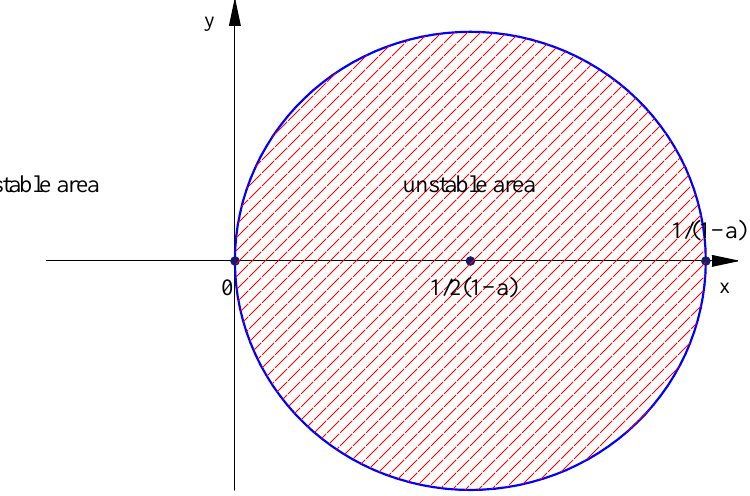
Figure 2. Stability domain and unstability domain of system